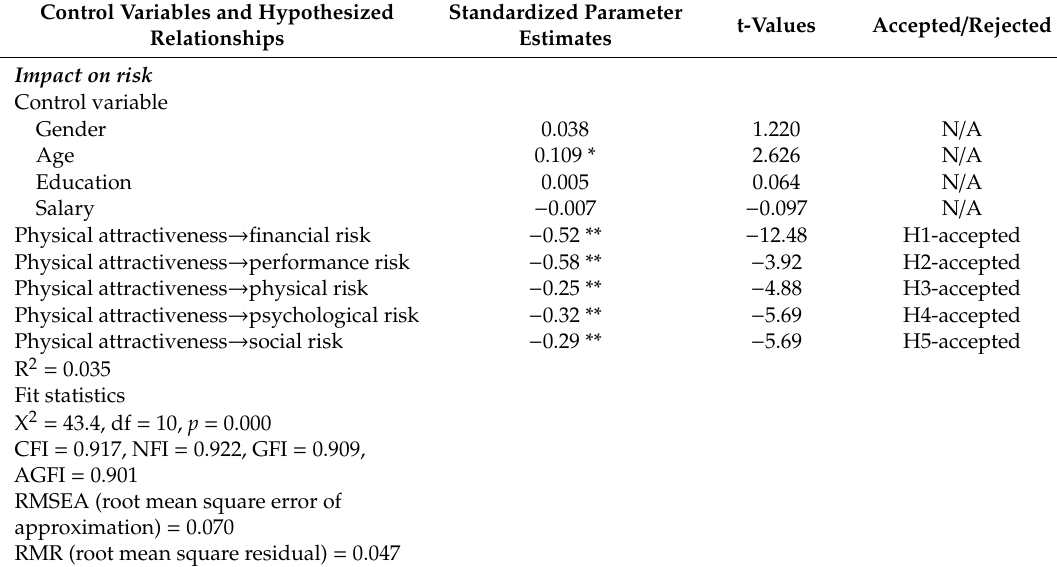
Table 4. Model test results. CFI, comparative fit index; NFI, normed fit index; GFI, goodness-of-fit